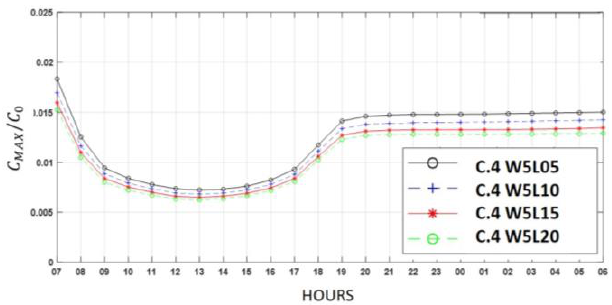
Fig. 5. Daily variation of the nondimensional maximum CO concentration C MAX /C 0 inside the courtyard 4, for the different simulated courtyard dimensions.